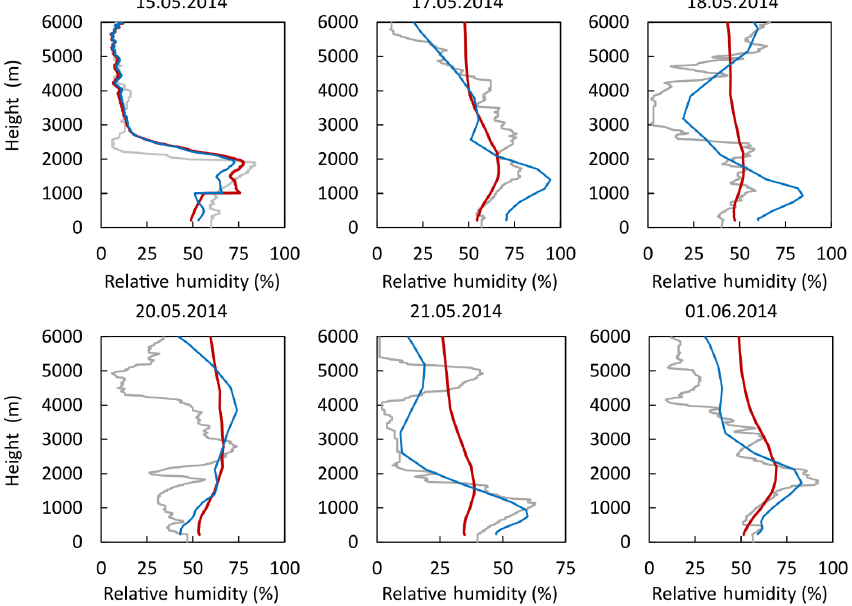
Figure 5. Vertical profiles of relative humidity from WRF model simulations (blue), microwave radiometer (red) and radiosoundings (grey). Table 2. Determination coefficients ( R 2 ) between various measurements techniques or simulations of relative humidity profiling and high- resolution radiosounding for different height regions. LD: lidar, MWR: microwave radiometer, WRF: WRF model. R 2 MWR WRF LD-MWR LD-WRF Height regions Low Mid. Full Low Mid. Full Low Mid. Full Low Mid. Full